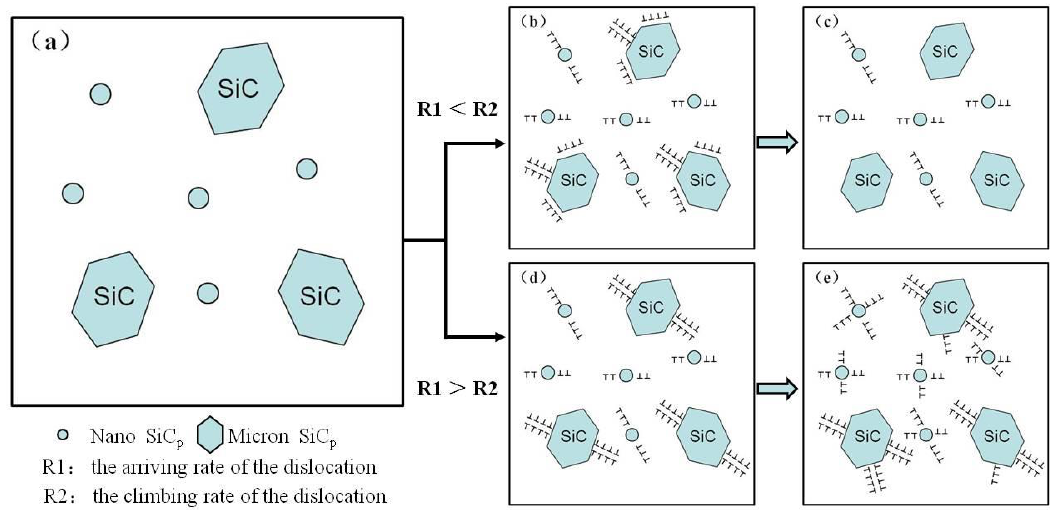
Figure 10. Model of dislocation particulate interactions of the dual-scale SiCp/A356 composites. ( a ) the initial microstructure, ( b ) dislocations pile-up around SiC particles, ( c ) dislocation climb, ( d ) dislocation accumulate, ( e ) dislocation structure with the increase of the dislocation accumulation degree.